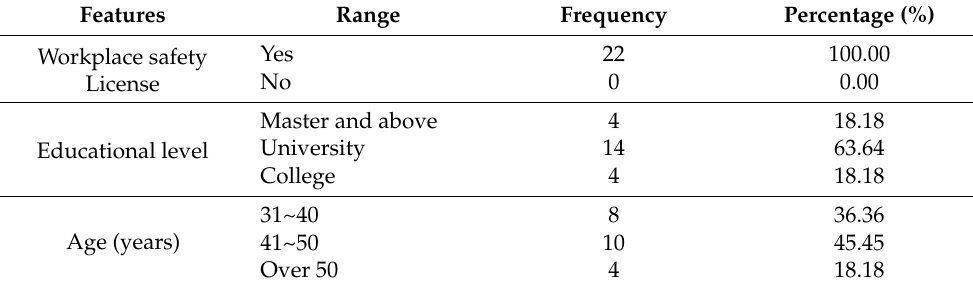
Table 4. Profiles of the